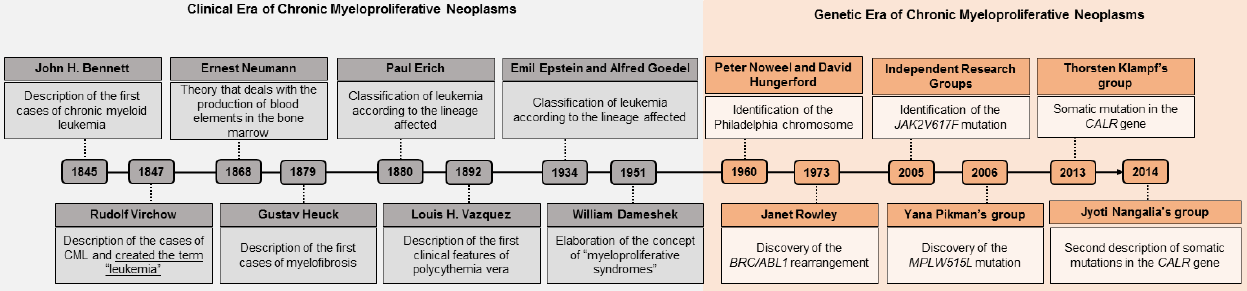
Table 1. Diagnosis criteria for classic BCR/ABL1 negative chronic myeloproliferative neoplasms.